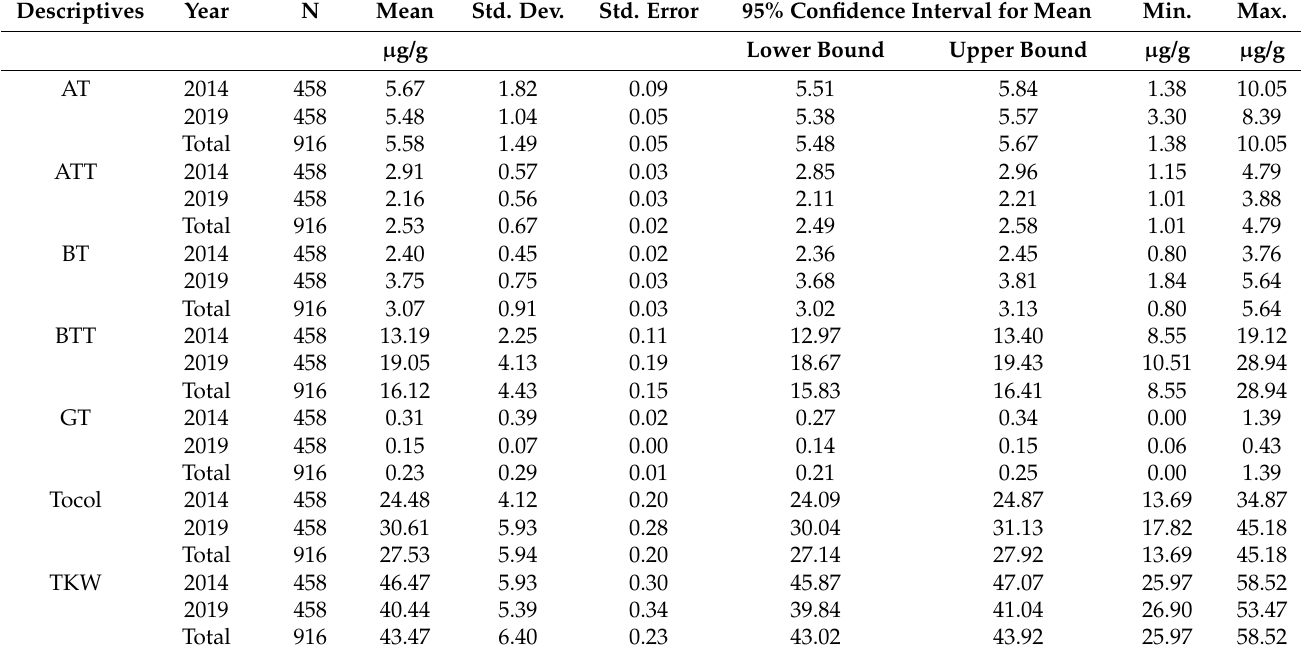
Table 1. Mean, standard deviation, and minimum and maximum values of tocopherols and to- cotrienols in 230 lines of Mv Toborz ó /Tommi population in 2 years (2014 and